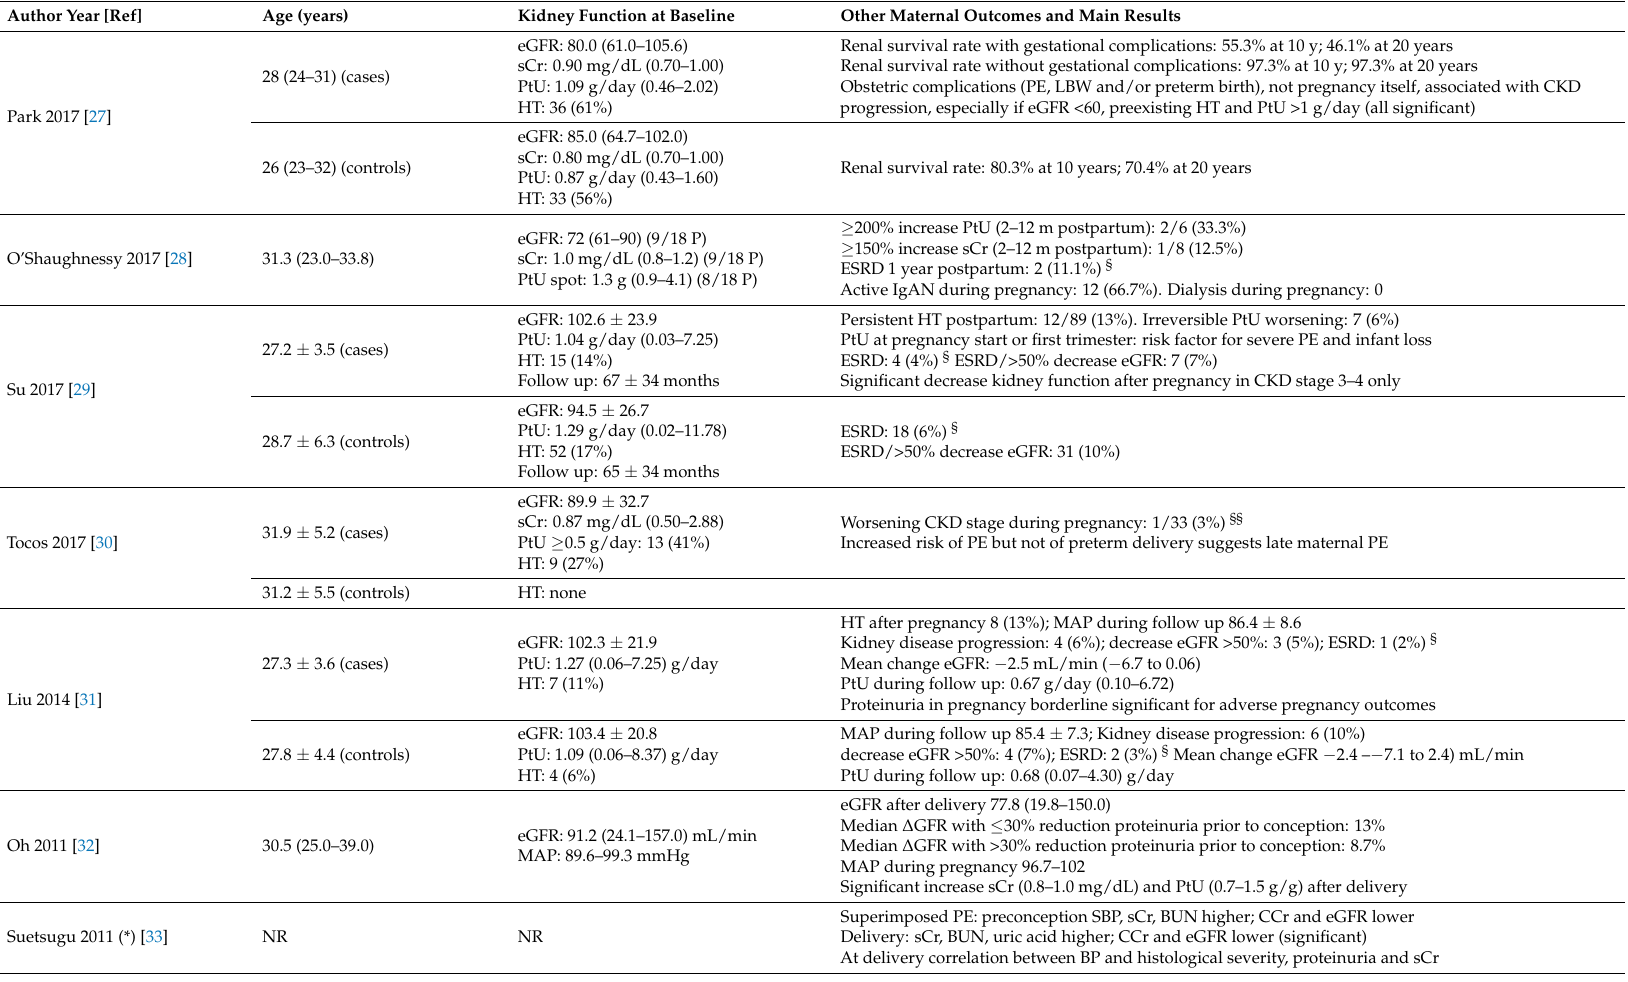
Table 4. IgA Nephropathy. Kidney function and other maternal outcomes in the case series reporting on